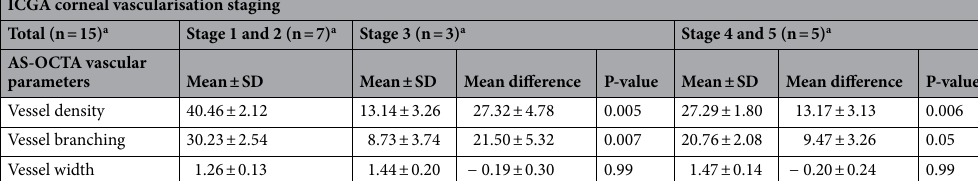
Table 1. Linear mixed-effects model analyses comparing serial anterior segment optical coherence tomography angiography (AS-OCTA) determined parameters (vessel density, vessel branch area, vessel width) to indocyanine green angiography (ICGA) determined corneal vascularisation staging. a Observed number of images at various stages of corneal vascularisation through serial AS-OCTA and ICGA